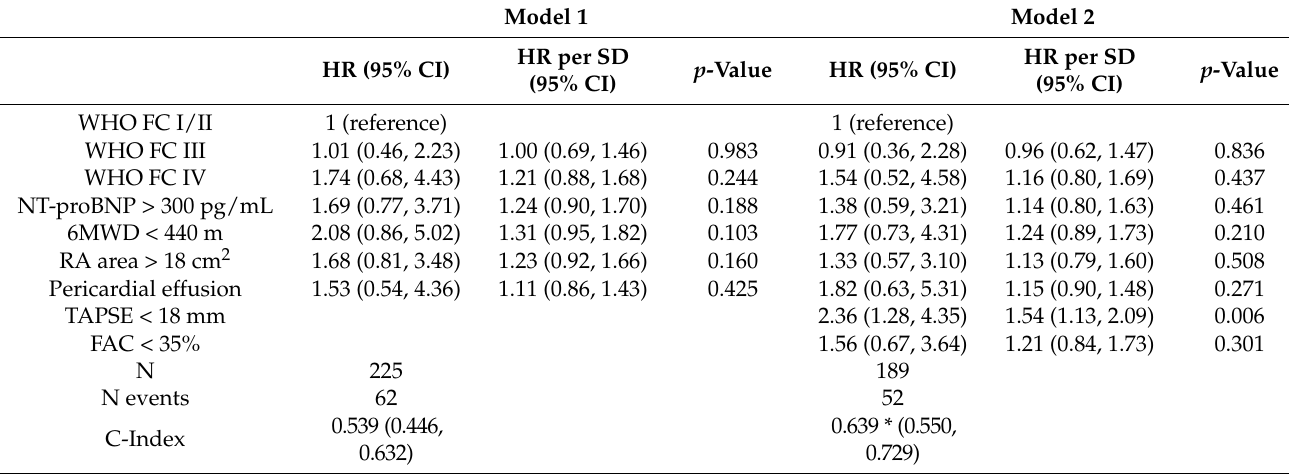
Table 3. Multivariable Cox regression models predicting all-cause mortality and lung